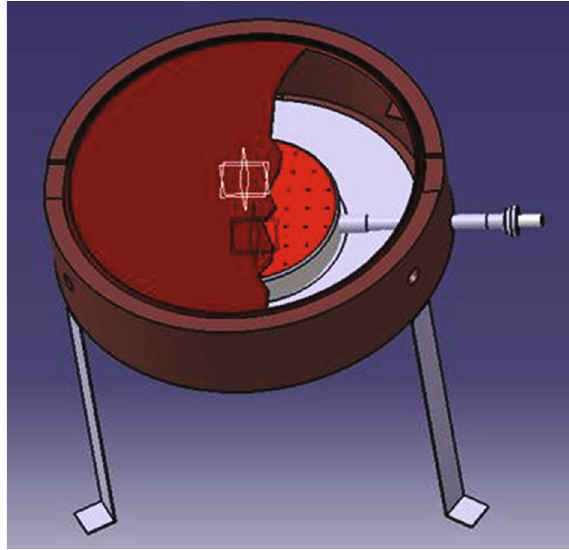
Figure 14: Biogas stove and